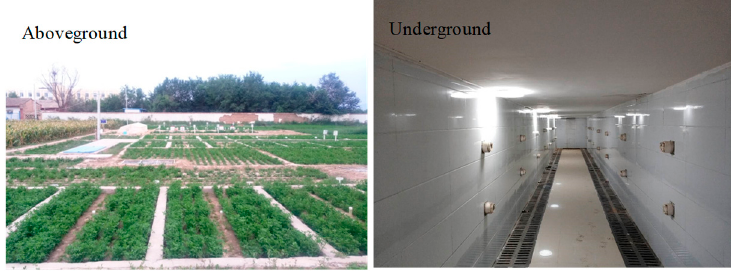
Figure 1. Lysimeters where the experiment was carried out.